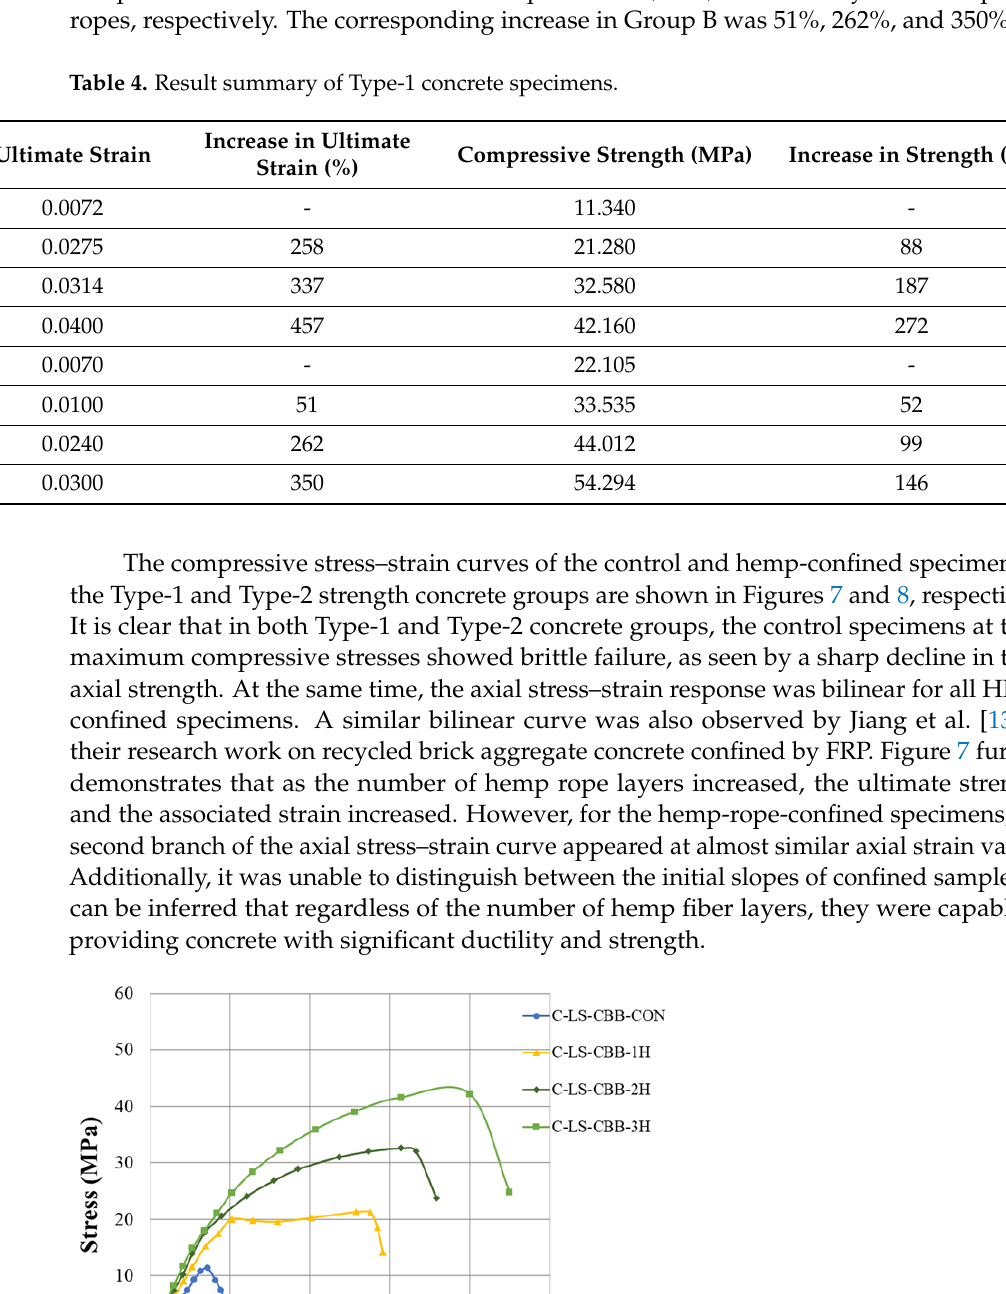
Figure 8. Stress – strain response of Type-2 concrete with and without hemp ropes confinement. 3.2. Hemp Rope Layers Effect on Type-1 and Type-2 Concrete The comparison of the increase in ultimate compressive strength and the correspond- ing strain of Type-1 and Type-2 concrete specimens confined by hemp ropes is shown in Figures 9 and 10, respectively. For one, two, and three layers of hemp rope confinement, the ultimate strength of Type-1 concrete specimens was greater than that of Type-2 con- crete specimens by 36%, 88%, and 126%, respectively. Similarly, the ultimate strain of Type-1 concrete specimens was greater than that of Type-2 concrete specimens by 207% for one, 75% for two, and 107% for three layers of hemp ropes. The performance of hemp rope confinement in Type-1 was better than that in Type-2 concrete. However, there is a positive association between the number of layers of hemp rope and the increase in ulti- mate strength and strain.